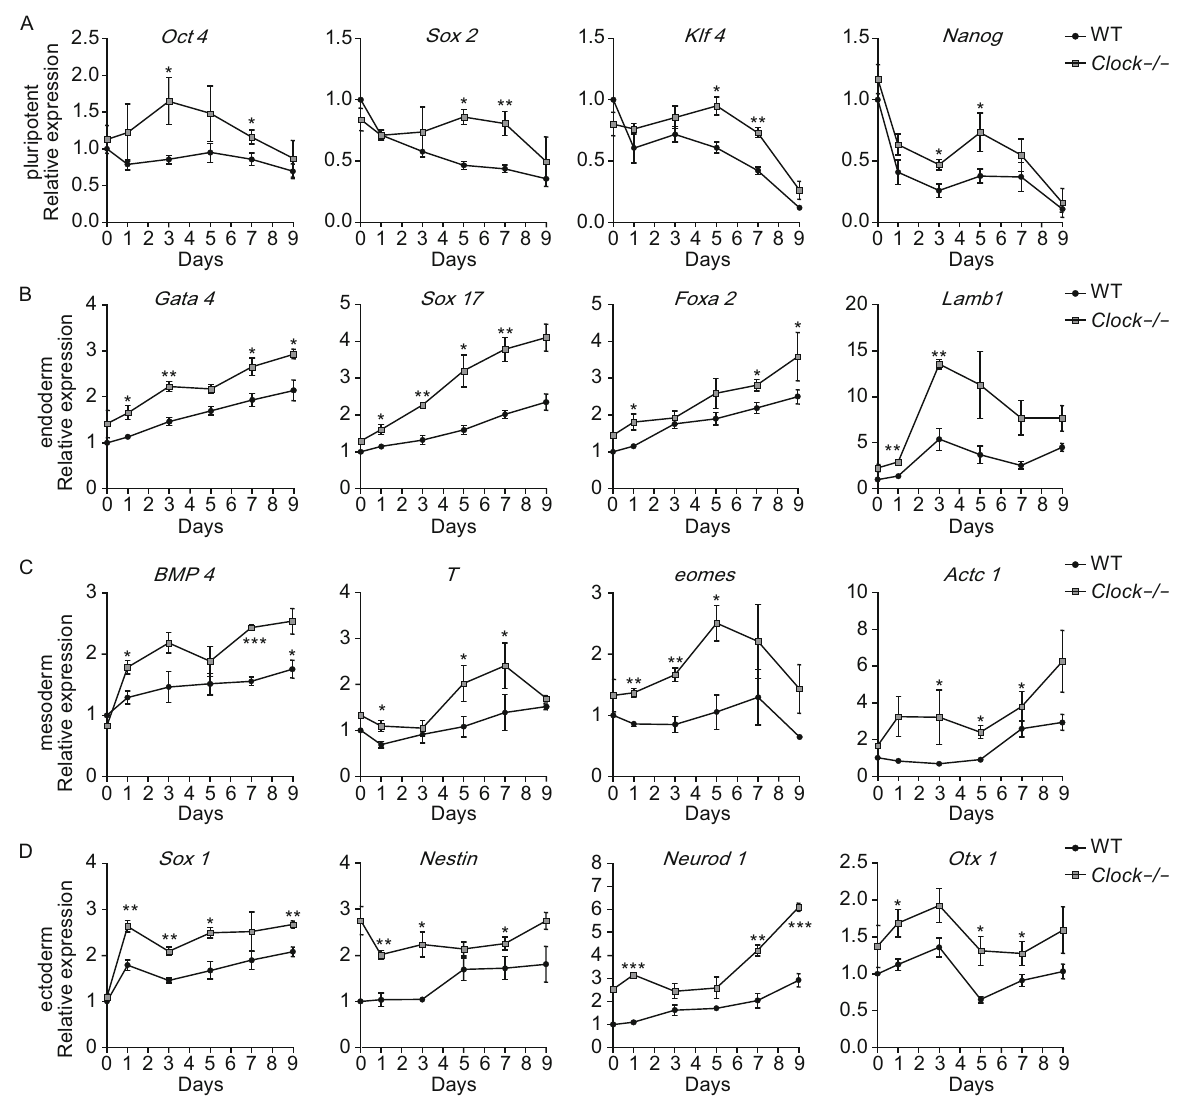
Figure 7. Clock silencing promoted the expression of genes controlling the three embryonic germ layers in spontaneously differentiated mESCs. (A) Relative mRNA expression of pluripotent markers Oct4, Sox2, Nanog, and Klf4 after spontaneous differentiation in wild type and Clock -/- mESCs. Expression of the pluripotent genes was gradually decreased in wild type and Clock -/- mESCs. (B) Relative mRNA expression of endoderm markers Gata4, Sox17, Foxa2, and Lamb1 after spontaneous differentiation in wild type and Clock -/- mESCs. Clock -/- mESCs exhibited a higher expression of these endoderm genes. (C) Relative mRNA expression of mesoderm markers BMP4, T, Eomes, and Actc1 after spontaneous differentiation in wild type and Clock -/- mESCs. Clock -/- mESCs exhibited a higher expression of mesoderm genes. (D) Relative mRNA expression of ectoderm markers Nestin, Sox1, Neurod1, and Otx1 after spontaneous differentiation in wild type and Clock -/- mESCs. Clock -/- mESCs exhibited a higher expression of these ectoderm genes. The mRNA expression levels were normalized with that of the endogenous GAPDH . Data represent the average of three independent experiments and are presented as means ± S.D. Statistical signi fi cance was calculated using the Student ’ s t -test: *denotes P < 0.05, **denotes P < 0.01, ***denotes P < 0.001 compared with the Ctrl group, ns, not signi fi